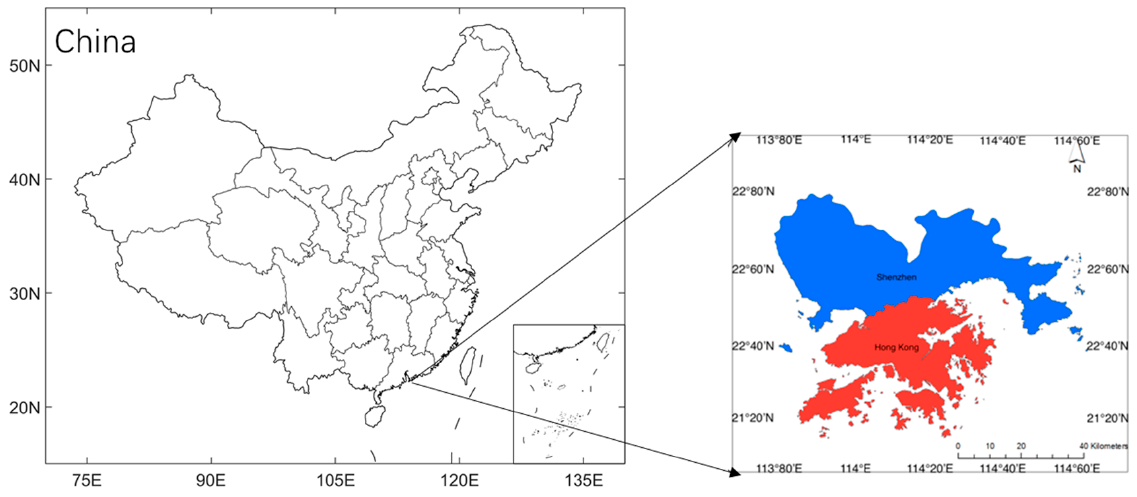
Figure 1. Study areas of Hong Kong (red) and Shenzhen (blue).